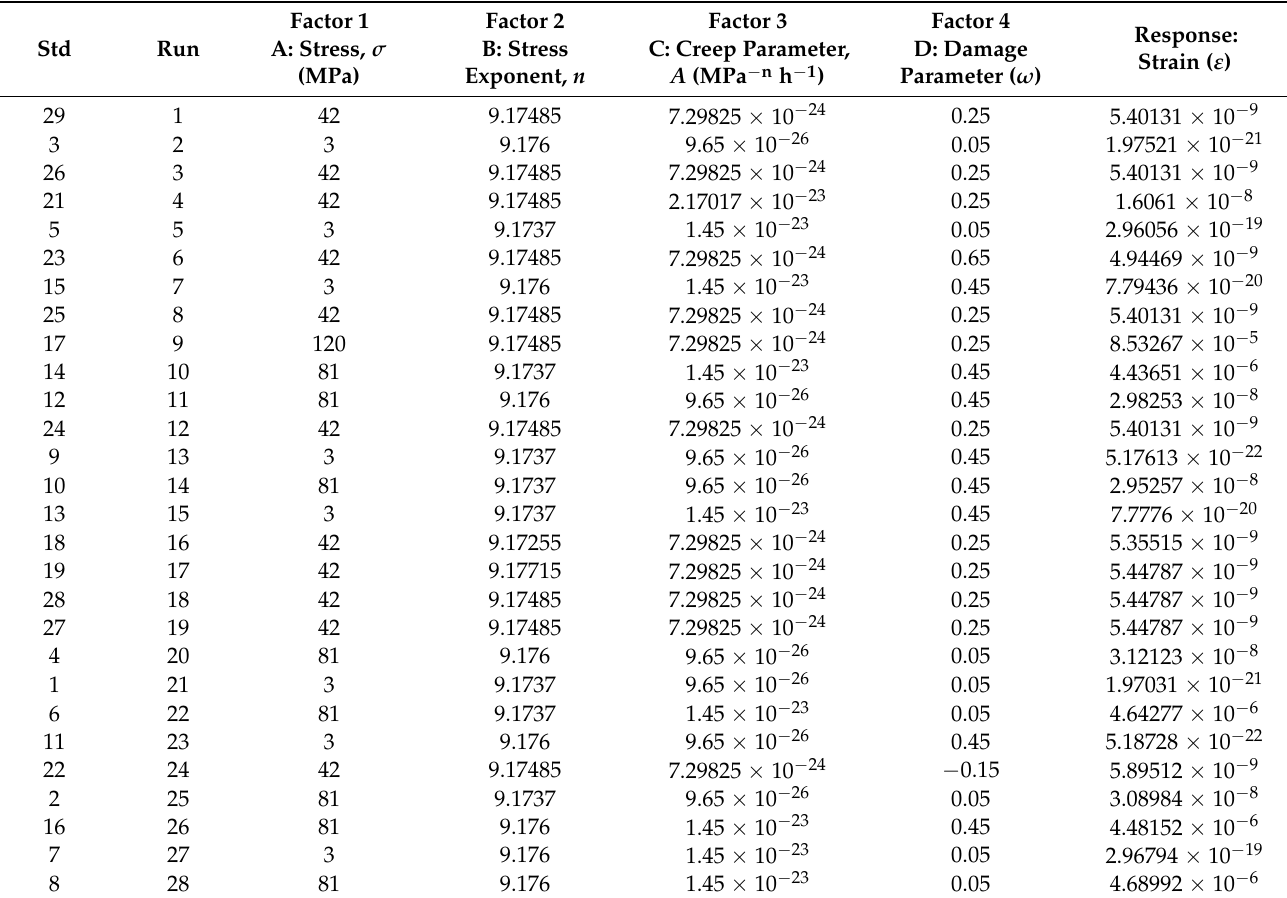
Table 4. Design matrix of factors and